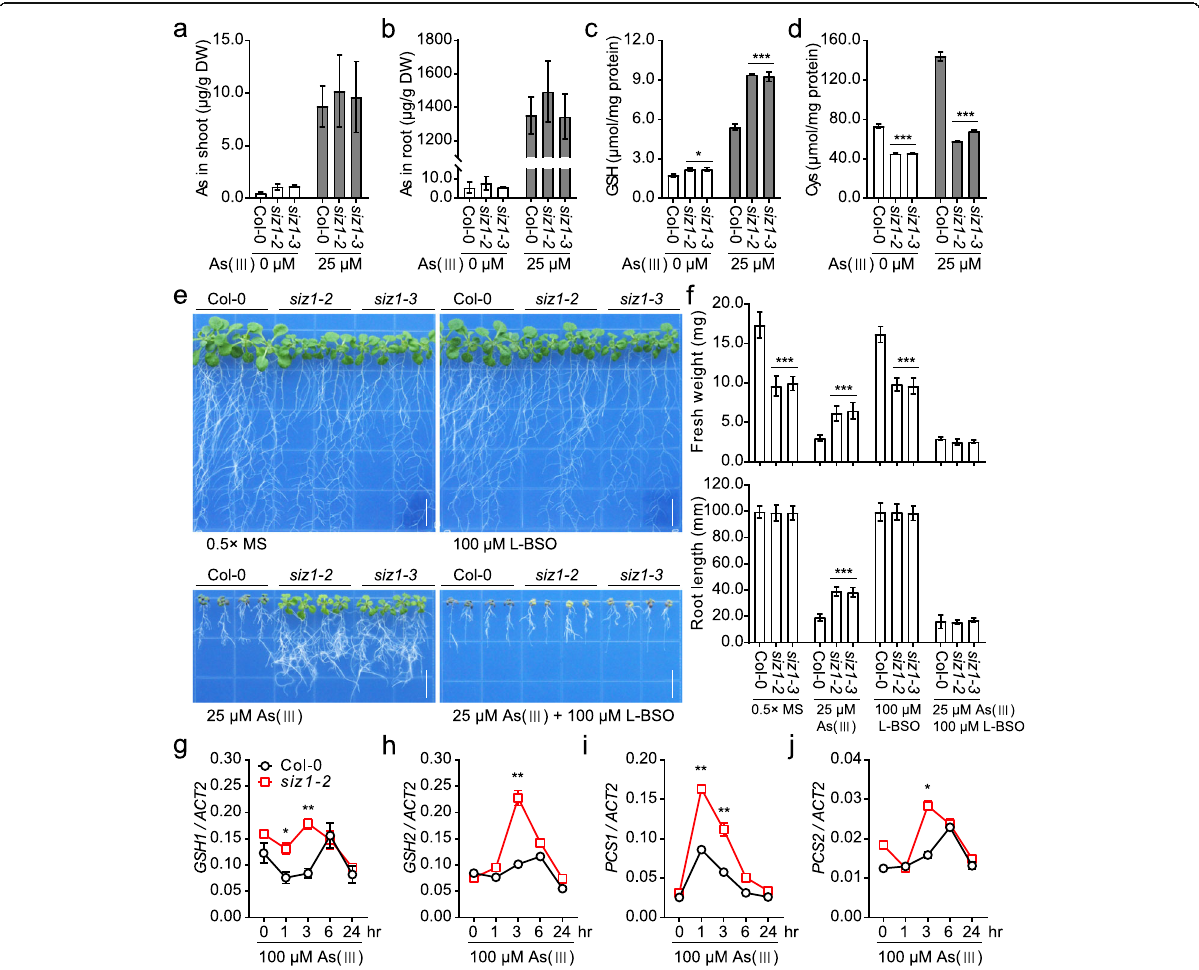
Fig. 3 Arsenite-resistant phenotype of siz1 mutants is suppressed by the inhibition of GSH accumulation. a , b Arsenic contents measured by ICP- MS analysis in shoot ( a ) and root ( b ) of 7-day-old Col-0, siz1 – 2 , and siz1 – 3 seedlings after As (III) treatment for 4 days. c , d The contents of GSH ( c ) and cysteine ( d ) in 7-day-old Col-0, siz1 – 2 , and siz1 – 3 seedlings after As (III) treatment for 4 days. e The effect of L-BSO on arsenite-resistance of siz1 mutants. Five-day-old seedlings grown on 0.5× MS medium were transferred to the medium supplemented with 25 μ M As (III), 100 μ M L-BSO, or combination of 25 μ M As (III) and 100 μ M L-BSO for 12 days. Bar, 1 cm. ( f ) Fresh weight and root length from the seedlings shown in ( e ). Values are means ± SD of three replicates, each replicate containing 9 plants per genotype. *** P < 0.001, Student ’ s t test. g - j The transcript abundance of GSH1 ( g ), GSH2 ( h ), PCS1 ( i ), and PCS2 ( j ) determined by qRT-PCR analysis in Col-0 and siz1 – 2 seedlings after 100 μ M As (III) treatment for the indicated time. The ACT2 was used as an internal control. Values are means ± SD ( n = 3). * P < 0.05, ** P < 0.01, Student ’ s t